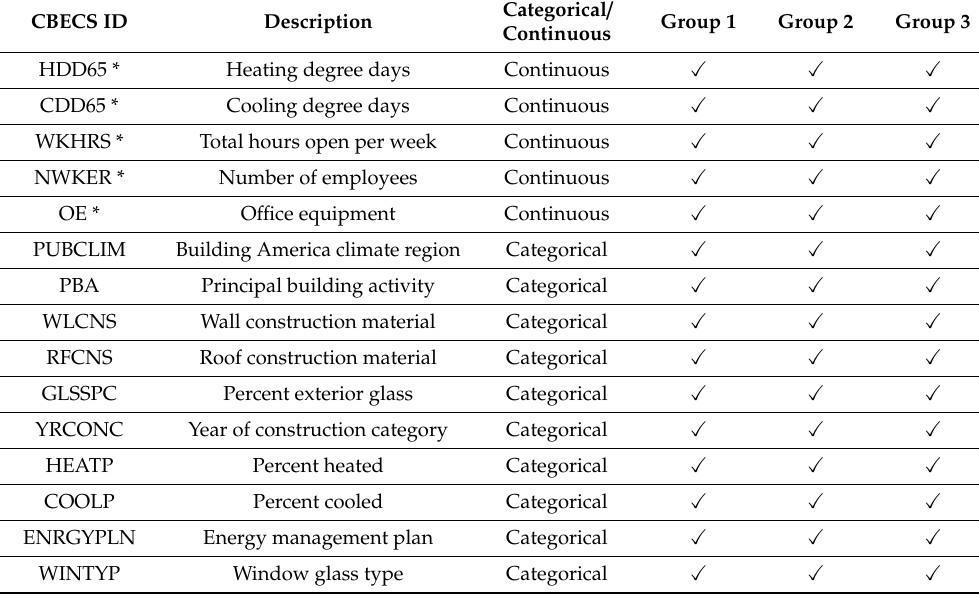
Table 2. Partial list of input predictors used for developing prediction models. Note: * indicates that the feature engineering technique was applied to the predictors (Table S1 for entire list.). Commercial Building Energy Consumption Survey =